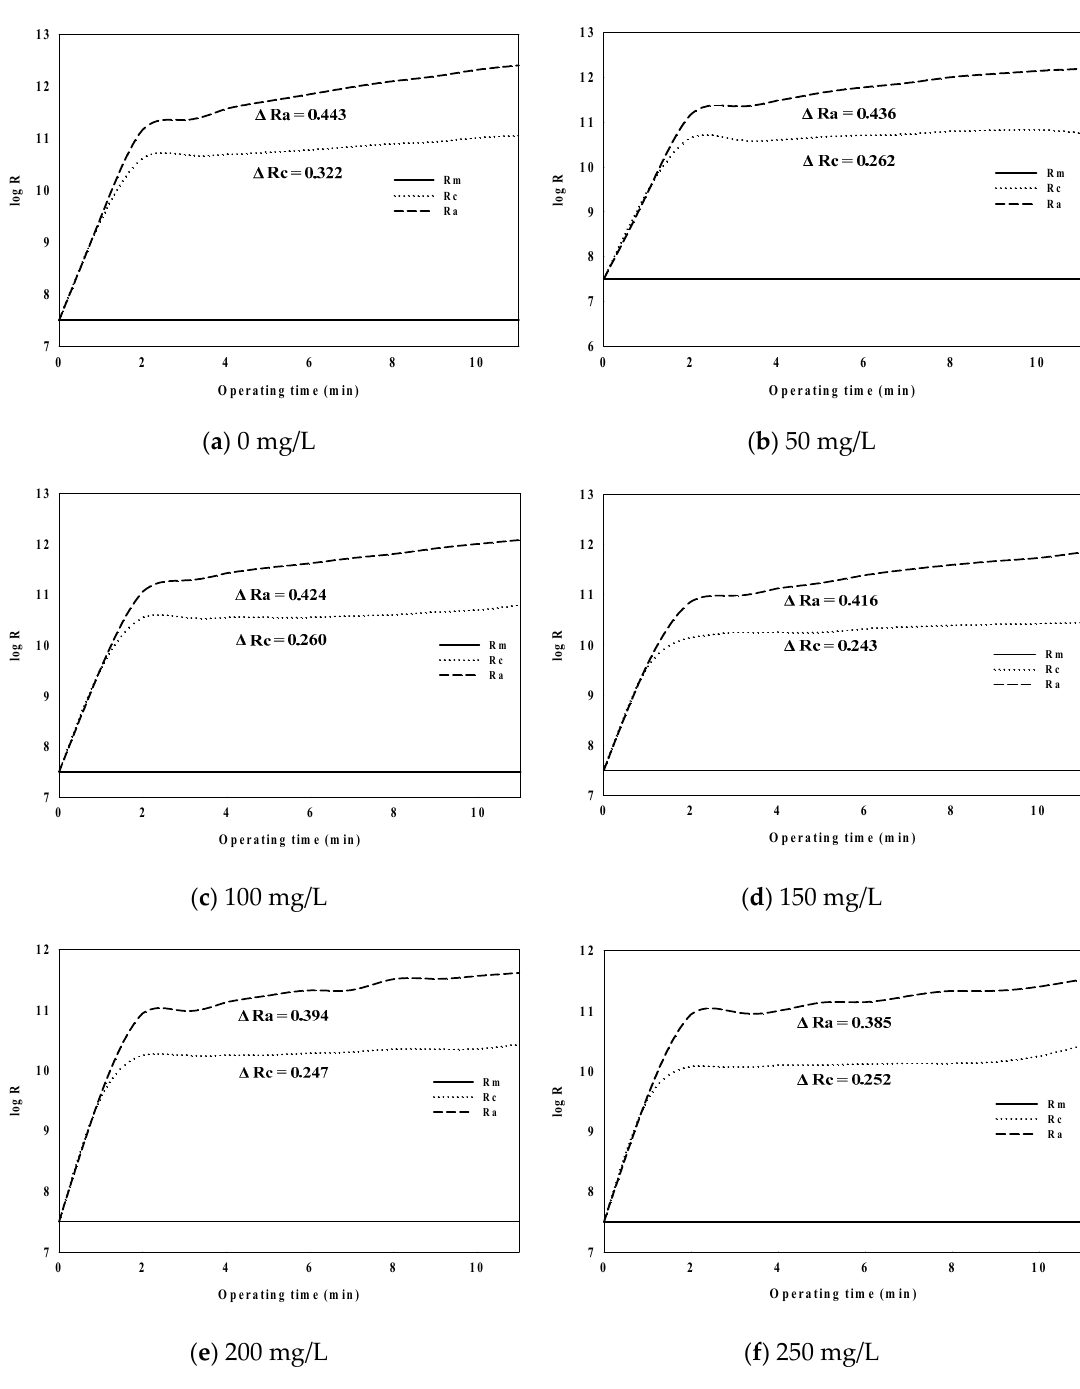
Figure 4. Behaviors of R a and R c with time.